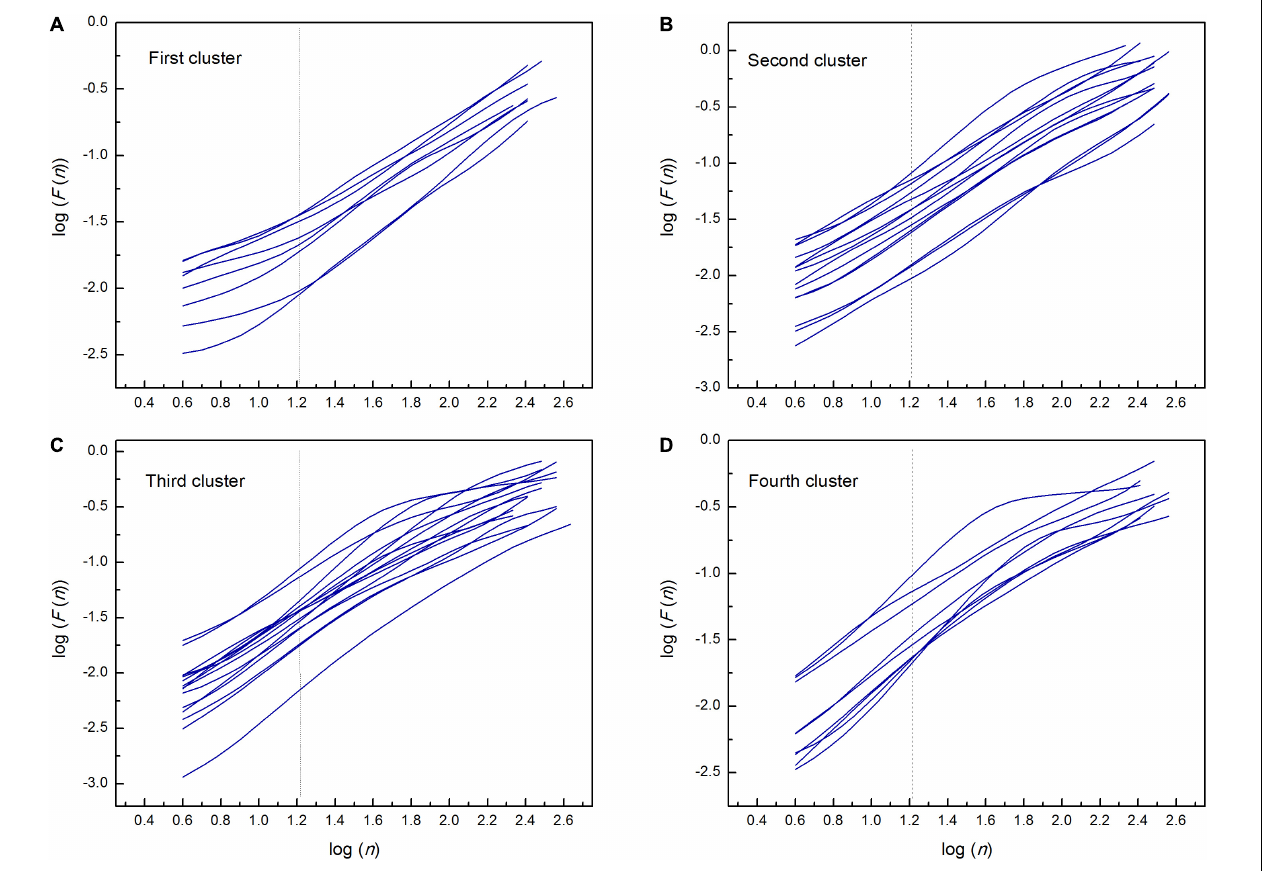
FIGURE 2 | Detrended fluctuation functions F ( n ) for time series of interbeat intervals versus segment size n on the log-log graph; in the first (A) , second (B) , third (C) , and fourth (D) cluster of heart failure patients. Dashed lines separate the two ranges in which the scaling exponents have been determined ( n = 16). Estimated scaling exponents with the coefficient of determination for every patient in each cluster are given in Tables 2–5 .